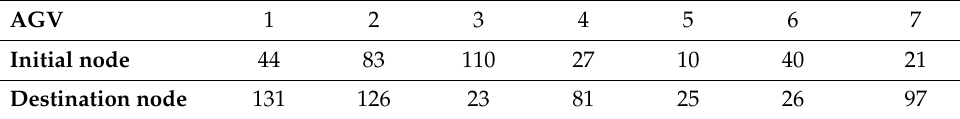
Figure 12. Result of route planning by the proposed method. Table 2. Initial condition.